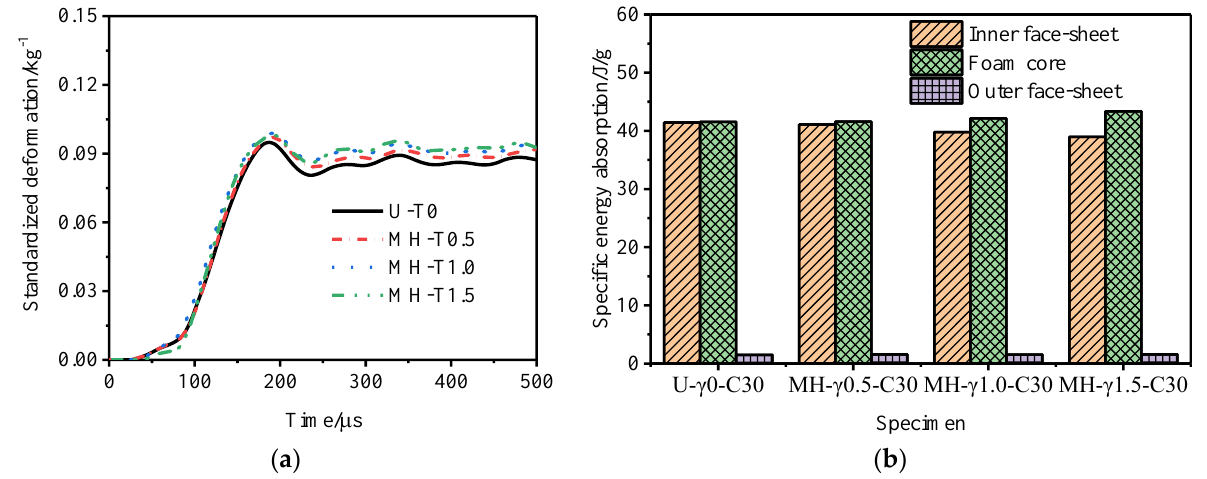
Figure 16. Anti − explosion performance of an MH-type aluminum foam sandwich tube. ( a ) Defor-